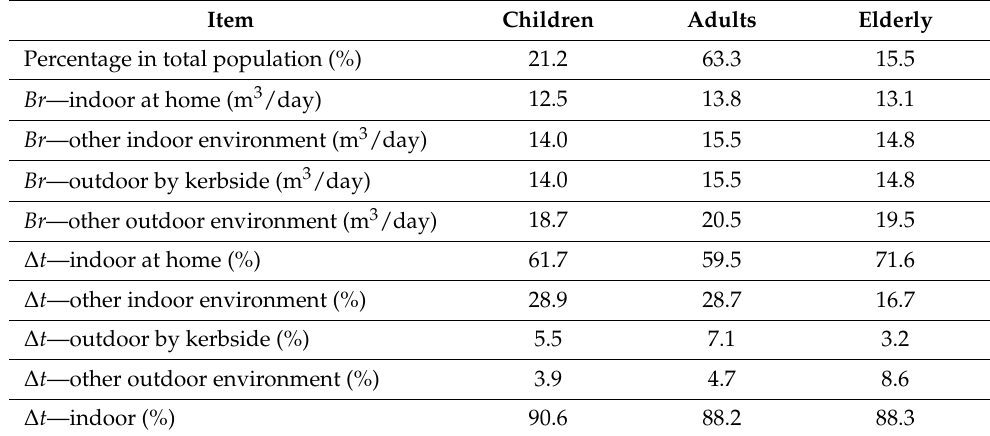
Table 2. Critical factors for exposure assessment.